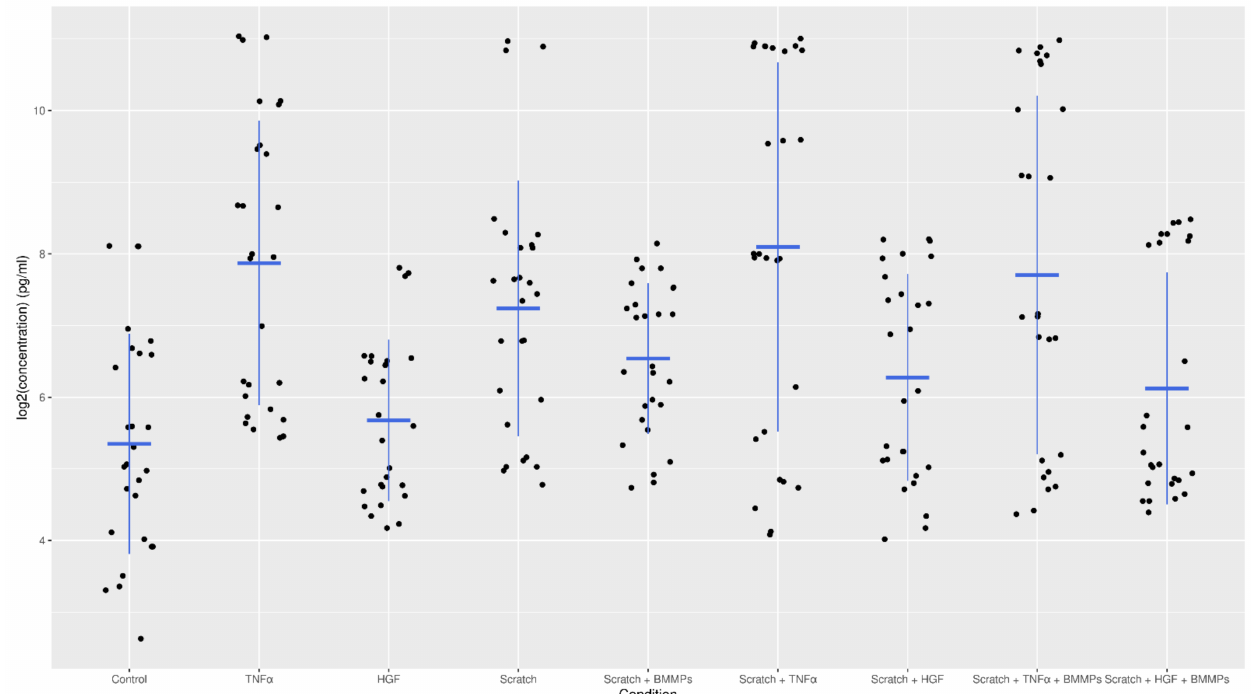
Figure A4. Strip plot of log2 concentration in pg/mL of FGF-1, IL-8, and SCF against the different conditions for the three biological